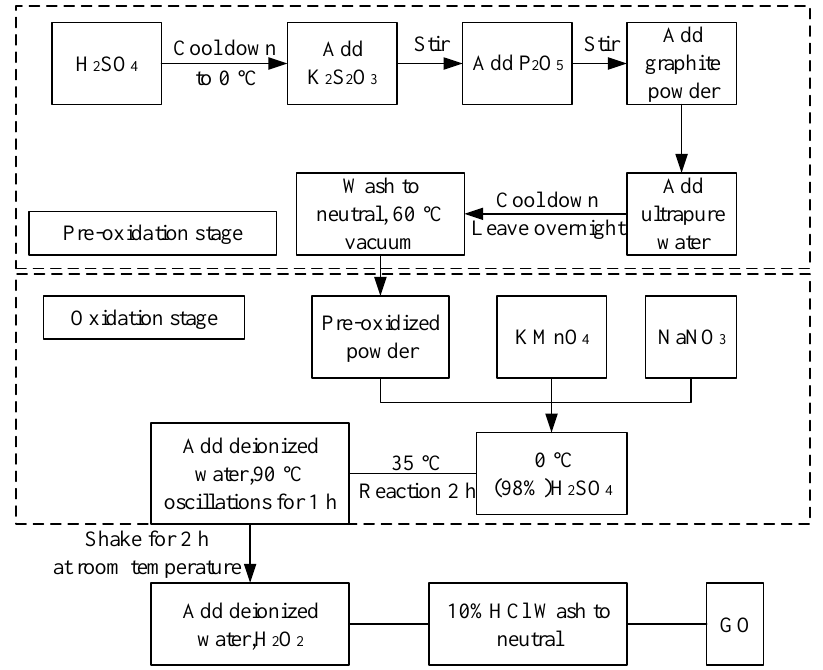
Figure 1. Technical roadmap for the preparation of graphene oxide (GO) dispersion.